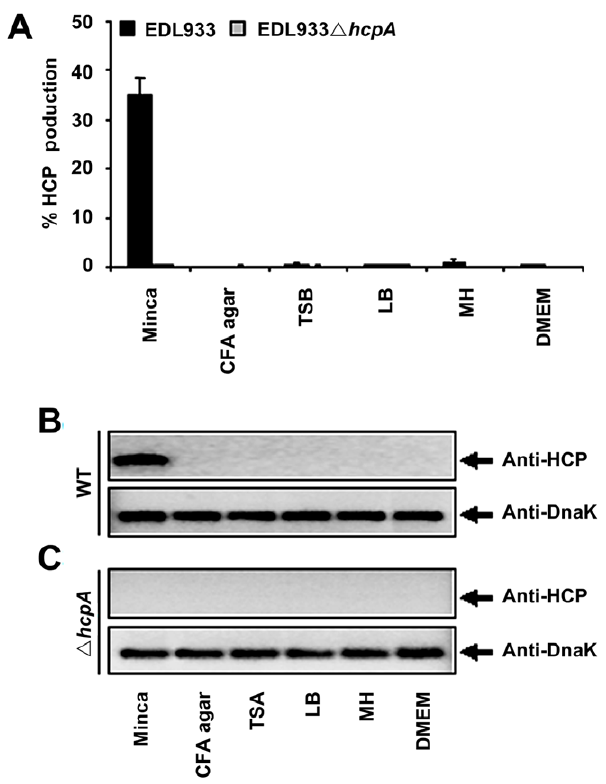
Figure 1. Production of HCP from EHEC EDL933 strain. Flow cytometry data from the EHEC EDL933 strain cultured in different media showing optimal production of HCP after bacterial growth in Minca (A). Western blot confirming HCP production by EDL933 in Minca (B). The EDL933 D hcpA strain was used as a negative control (C). Detection of DnaK with anti-DnaK antibody was used to ensure that equal amounts of antigen were tested.